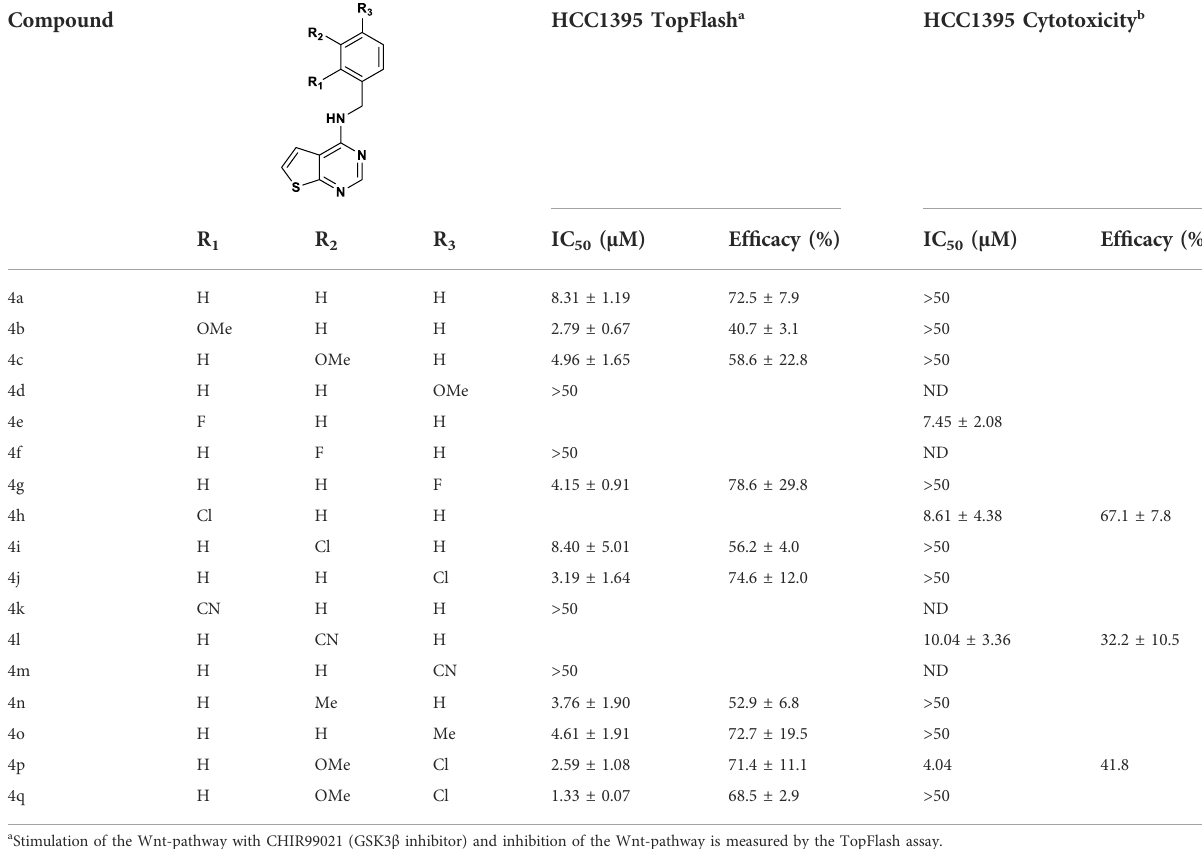
TABLE 1 SAR exploration of the benzyl top part of thieno[2,3-d]pyrimidine. Compound